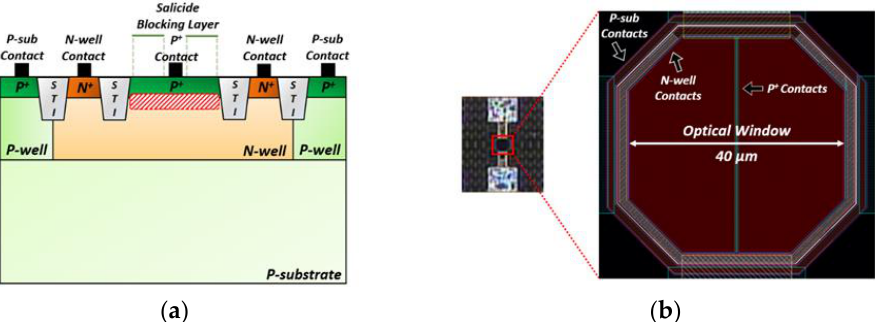
Figure 2. ( a ) Cross-sectional view of the proposed on-chip CMOS P+/N-well avalanche photodiode (APD) and ( b ) its chip photomicrograph and layout.